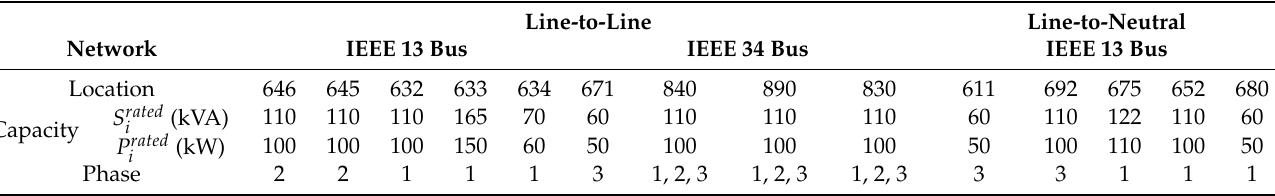
Table 1. Identification of single-phase PV